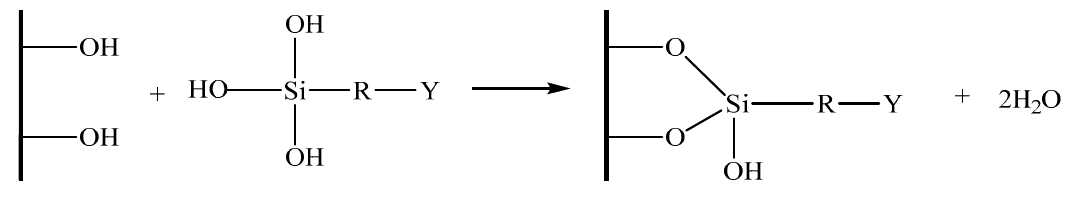
Figure 4. Silanization processing.